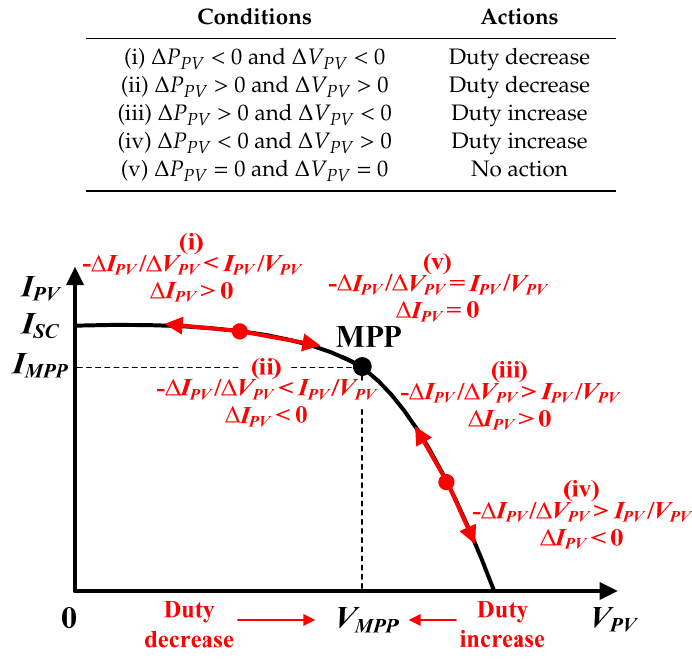
Figure 3. Principle of operation for the incremental conductance (INC) algorithm. Table 2. Methodology of the INC algorithm.